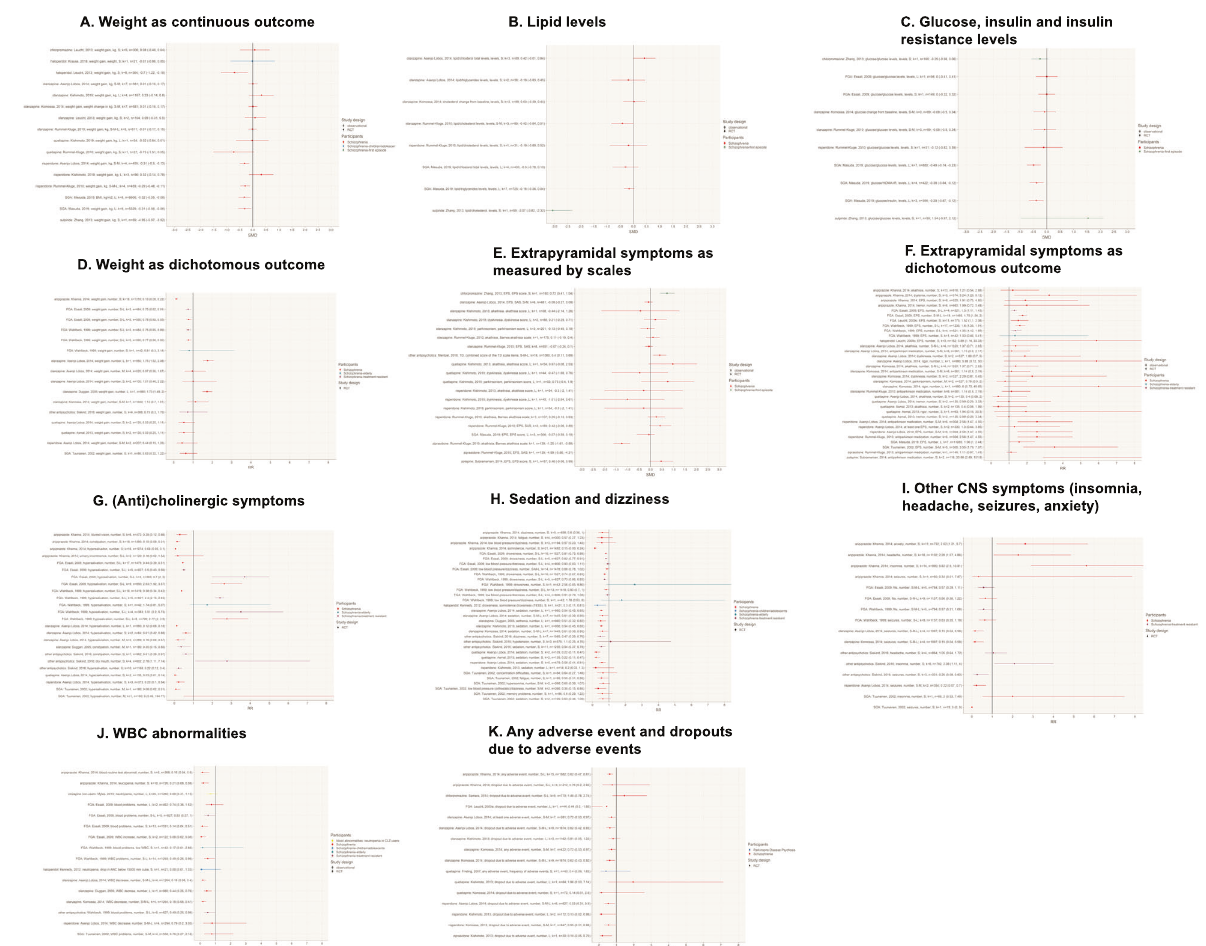
Fig. 3 Quantitative meta-review of clozapine-speci fi c meta-analytic data: adverse-events. A Weight as continuous outcome. BMI body- mass-index, k number of studies, kg kilogram, L long-term, M medium-term, n number of participants, RCT randomized-controlled trial, S short-term, SGA second-generation antipsychotic. For continuous outcomes, SMD > 0 means a bene fi cial outcome for clozapine (e.g. more response or less adverse events. B Lipid levels. k number of studies, L long-term, M medium-term, n number of participants, RCT randomized- controlled trial, S short-term, SGA second-generation antipsychotic. C Glucose, insulin and inulin resistance levels. FGA fi rst-generation antipsychotic, k number of studies, L long-term, M medium-term, n number of participants, RCT randomized-controlled trial, S short-term, SGA second-generation antipsychotic. For continuous outcomes, SMD > 0 means a bene fi cial outcome for clozapine (e.g. more response or less adverse events. D Weight as dichotomous outcome. FGA fi rst-generation antipsychotic, k number of studies, L long-term, M medium-term, n number of participants, RCT randomized-controlled trial, S short-term, SGA second-generation antipsychotic. For dichotomous outcomes, RR > 1 means a bene fi cial outcome for clozapine (e.g. more response or less adverse events/dropouts). E Extrapyramidal symptoms as measured by scales. k number of studies, L long-term, M medium-term, n number of participants, RCT randomized-controlled trial, S short-term, SAS Simpson – Angus Scale, SGA second-generation antipsychotic, TD tardive dyskinesia. For continuous outcomes, SMD > 0 means a bene fi cial outcome for clozapine (e.g. more response or less adverse events. F Extrapyramidal symptoms as dichotomous outcome. EPS extrapyramidal symptoms, FGA fi rst-generation antipsychotic, k number of studies, L long-term, M medium-term, n number of participants, RCT randomized- controlled trial, S short-term, SGA second-generation antipsychotic. For dichotomous outcomes, RR > 1 means a bene fi cial outcome for clozapine (e.g. more response or less adverse events/dropouts). G (Anti-)cholinergic symptoms. FGA fi rst-generation antipsychotic, k number of studies, L long-term, M medium-term, n number of participants, RCT randomized-controlled trial, S short-term, SGA second-generation antipsychotic. For dichotomous outcomes, RR > 1 means a bene fi cial outcome for clozapine (e.g. more response or less adverse events/ dropouts). H Sedation and dizziness. FGA fi rst-generation antipsychotic, k number of studies, L long-term, M medium-term, n number of participants, RCT randomized-controlled trial, S short-term, SGA second-generation antipsychotic. For dichotomous outcomes, RR > 1 means a bene fi cial outcome for clozapine (e.g. more response or less adverse events/dropouts). I Other CNS symptoms (insomnia, headache, seizures, anxiety). FGA fi rst-generation antipsychotic, k number of studies, L long-term , M medium-term, n number of participants, RCT randomized- controlled trial, S short-term, SGA second-generation antipsychotic. For dichotomous outcomes, RR > 1 means a bene fi cial outcome for clozapine (e.g. more response or less adverse events/dropouts). J WBC abnormalities . FGA fi rst-generation antipsychotic, k number of studies, L long-term, M medium - term, n number of participants, RCT randomized-controlled trial, S short-term, WBC white blood count. For dichotomous outcomes, RR > 1 means a bene fi cial outcome for clozapine (e.g. more response or less adverse events/dropouts). K Any adverse event and dropouts due to adverse events. FGA fi rst-generation antipsychotic , k number of studies, L long-term, M medium-term, n number of participants, RCT randomized-controlled trial, S short-term. For dichotomous outcomes, RR > 1 means a bene fi cial outcome for clozapine (e.g. more response or less adverse